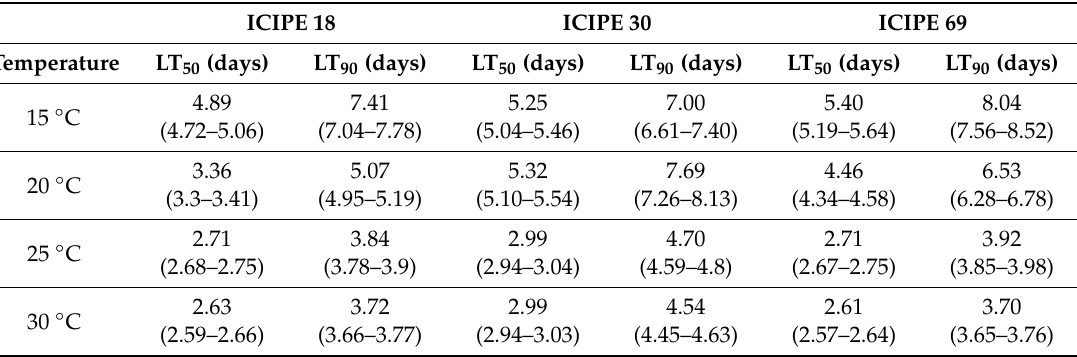
Table 4. Lethal time to 50% and 90% mortality of adult Z. cucurbitae caused by M. anisopliae isolates at different temperature regimes at 95% fiducial limit. ICIPE 18 ICIPE 30 ICIPE 69